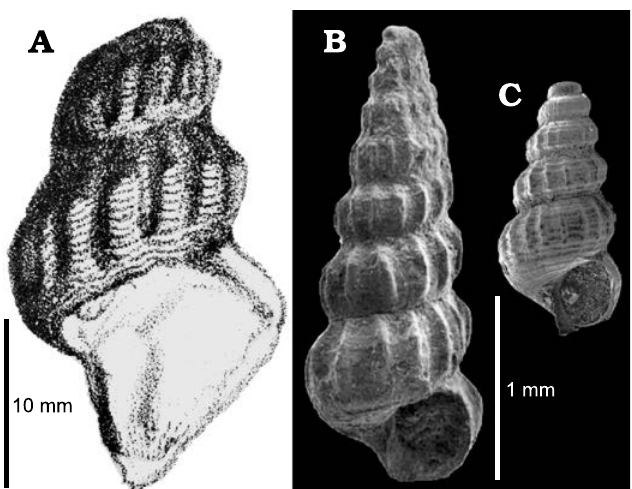
Fig. 2. Comparison between the holotype of zygopleurid? gastropod Ceri- thium ? lateplicatum Klipstein, 1843 and the specimens illustrated by Bandel (1995), here ascribed to a tofanellid Camponaxis bandeli sp. nov.; lower Carnian, eastern Dolomites (Southern Alps, northern Italy). A . Fragmentary type specimen (NHMUK PI OR 35701) of Cerithium ? lateplicatum , orig­ inal illustration from Klipstein (1843: pl. 11: 35). B , C . Camponaxis ban- deli sp. nov. B . Holotype, adult shell (RGM 219 039), from Bandel (1995: pl. 14: 5). C . Paratype, juvenile shell (RGM 219 040), from Bandel (1995: pl. 14: 3). Reproduced accordingly to CC­BY 4.0